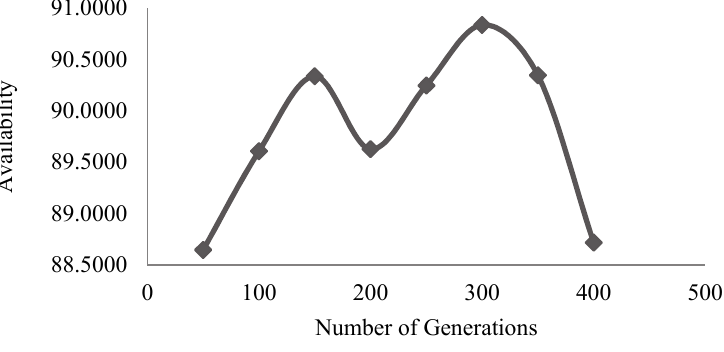
Fig. 4. Effect of Number of Generations on System Availability (Number of Particles